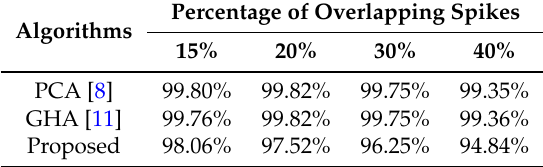
Table 9. The CSRs of the various feature extraction algorithms for different percentages of overlapping spikes. The spike source data are obtained by the simulator in